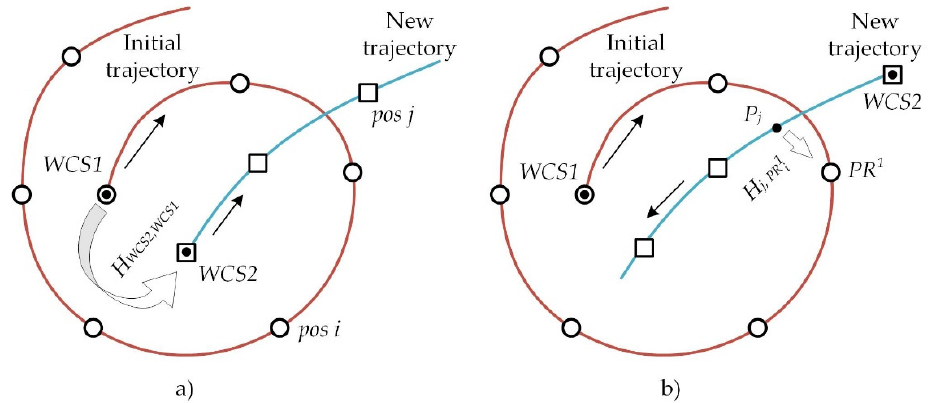
Figure 3. VCRN formation with two trajectories: ( a ) relating the trajectories at starting points with overlapping visibility areas; ( b ) relating a new trajectory with the initial one via PR 1 of the initial trajectory.